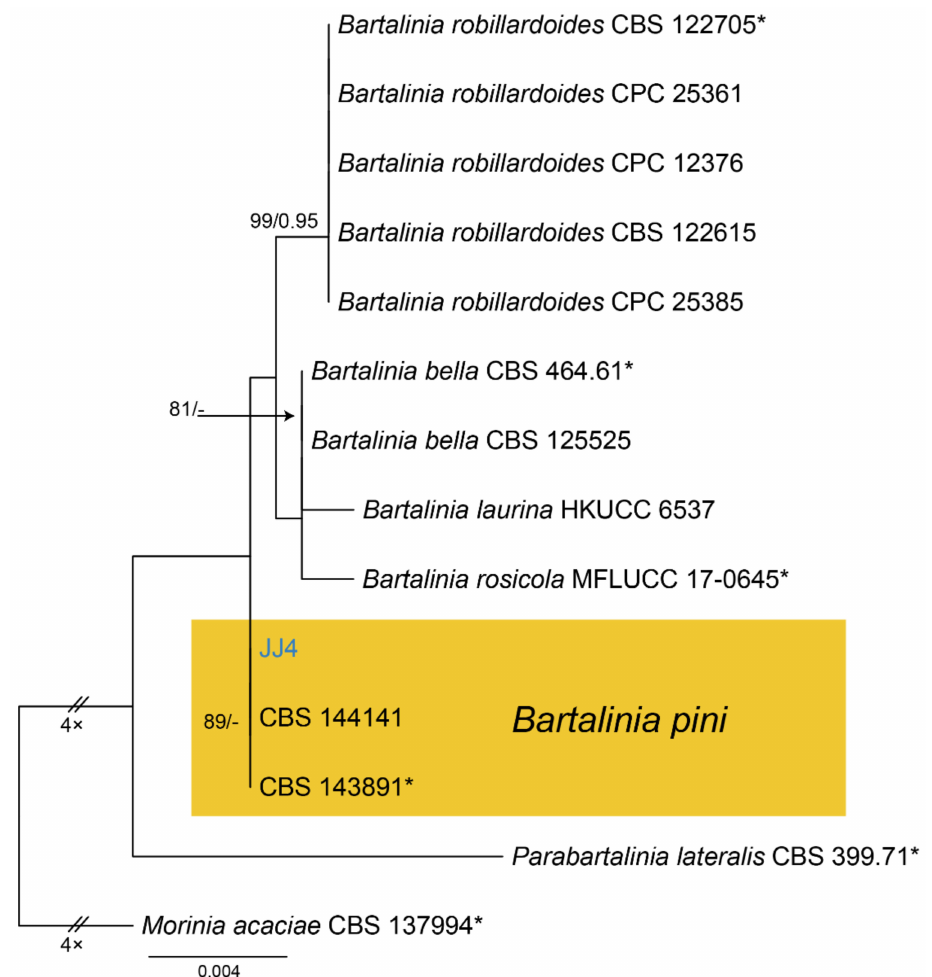
Figure A6. Phylogram generated from RAxML analysis based on combined ITS and LSU sequence data of Bartalinia isolates. Table 137994. The scale bar indicates 0.004 nucleotide changes per site. Isolate from this study is marked in blue, ex-type strains are marked with *, and the identified species is marked in